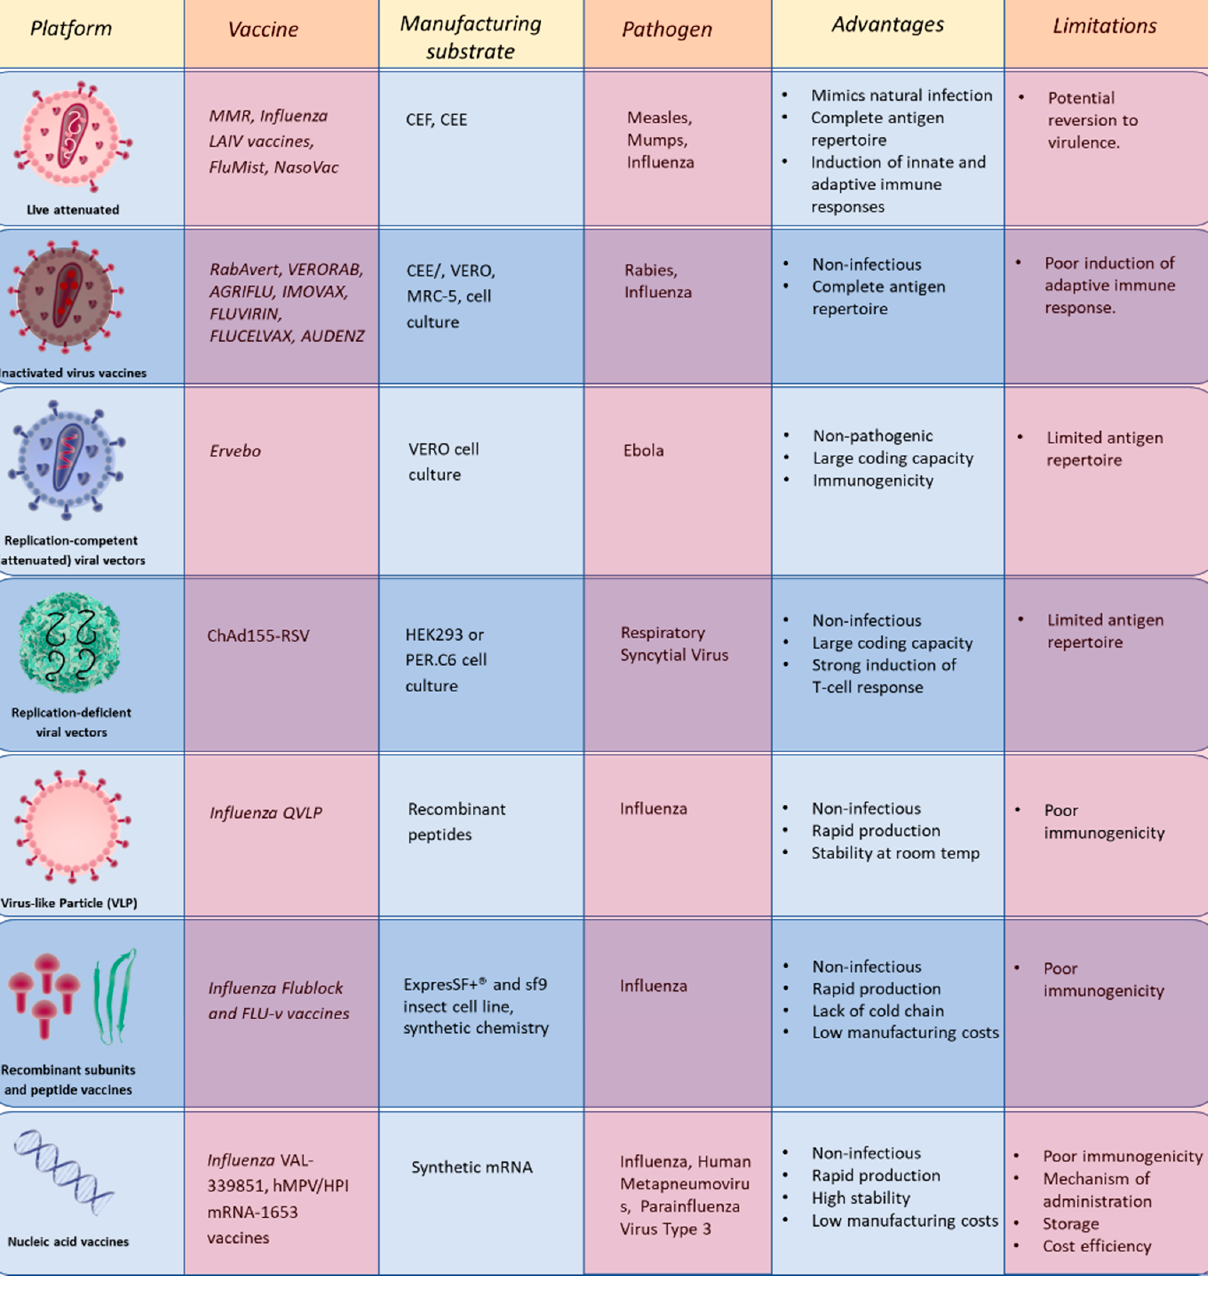
Figure 2. Vaccine design platforms used for the production of NSV vaccines. Description of platforms used to develop NSV vaccines, including examples, advantages, and limitations. CEF = Chicken Embryo Fibroblasts; CEE = Chicken Embryonated Eggs; expresSF+ and sf9 = Spodoptera frugiperda insect cell lines using a baculovirus expression vector system; HEK293 = Human Embryonic Kidney cells; PER.C6 = Human Embryonic Retinoblasts; VERO = African green monkey kidney cell line; MRC-5 = human fetal lung strain MRC-5; RSV = Respiratory Syncytial Virus; (ChAd155-RSV) = Chimpanzee-derived Adenovector harboring specific RSV proteins; hMPV/PIV = human metapneumovirus and parainfluenza virus type 3.